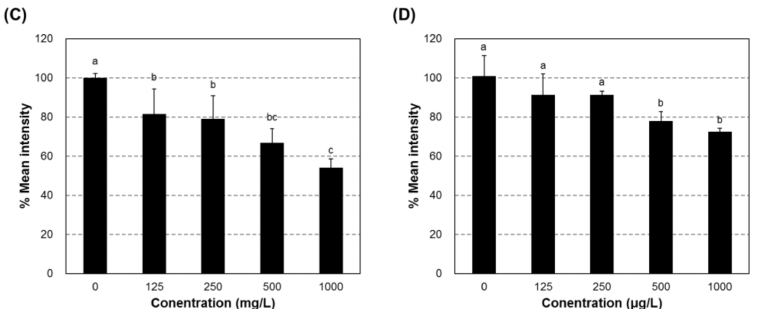
Figure 7. Pigment development in zebrafishes treated with compound #2 . Zebrafish embryos were exposed to either arbutin ( A ) or compound #2 ( B ) at indicated doses for 72 h. Upper, dorsal view; lower, lateral view. Pigmentation in zebrafish after exposure to arbutin ( C ) or compound #2 ( D ) was quantitatively measured. n = 5; error bars, mean ± SD. Different alphabetical letters indicate significant differences among the conditions ( p <